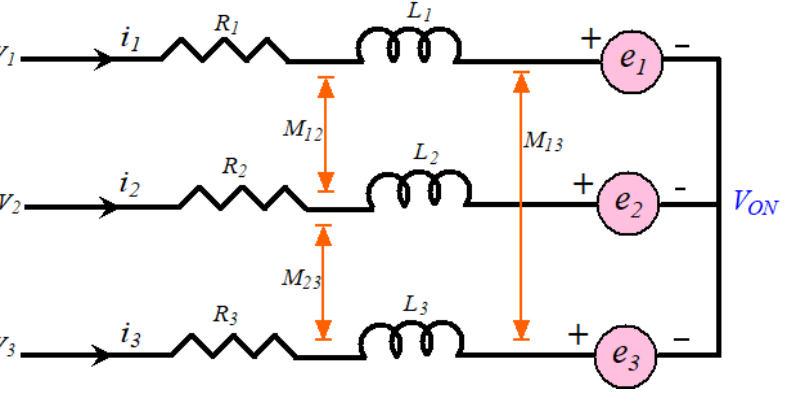
Figure 2. Equivalent winding structure of the BLDCM. In this figure, V 0 N is the voltage between ground and neutral point; V 1 , V 2 , and V 3 are the phase voltages (i.e., VSI pole voltage); i 1 , i 2 , and i 3 are the stator phase currents; R 1 , R 2 , and R 3 are phase winding resistances; e 1 , e 2 , and e 3 are the back-EMFs; L 1 , L 2 , and L 3 are the phase winding inductances; and M 12 , M 23 , and M 13 are mutual